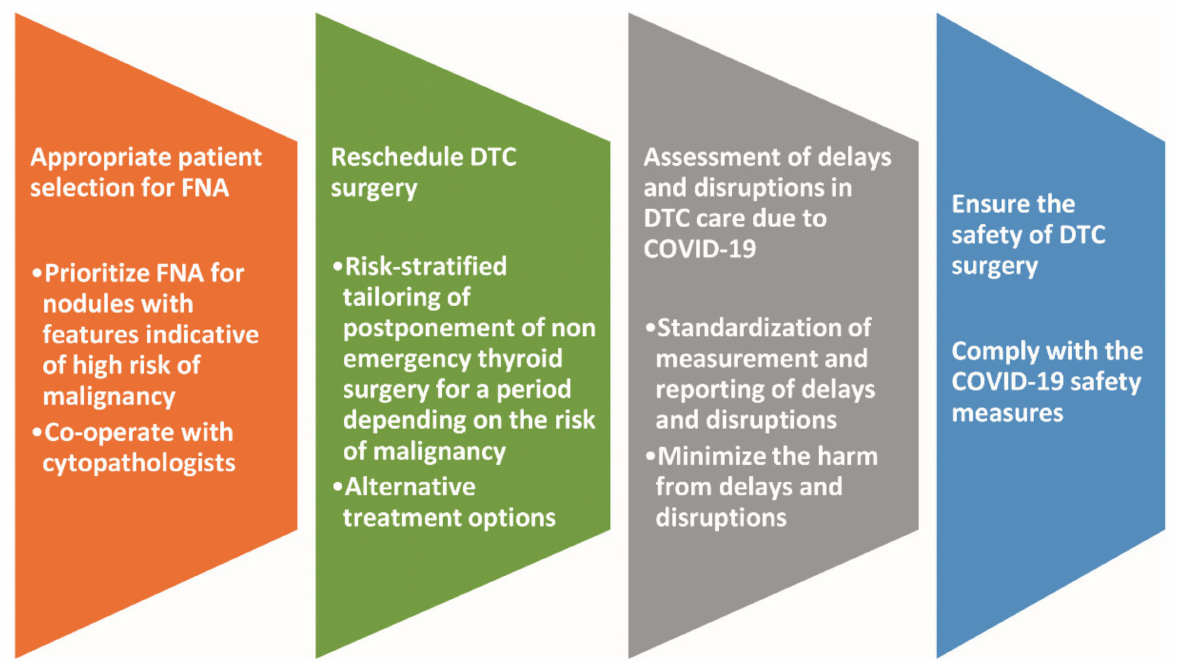
Figure 3. Challenges in the oncological strategy for DTC due to COVID-19 pandemic and the corresponding counter- acting initiatives. Abbreviations: COVID-19, coronavirus disease 19; DTC, differentiated thyroid carcinoma; FNA, fine needle